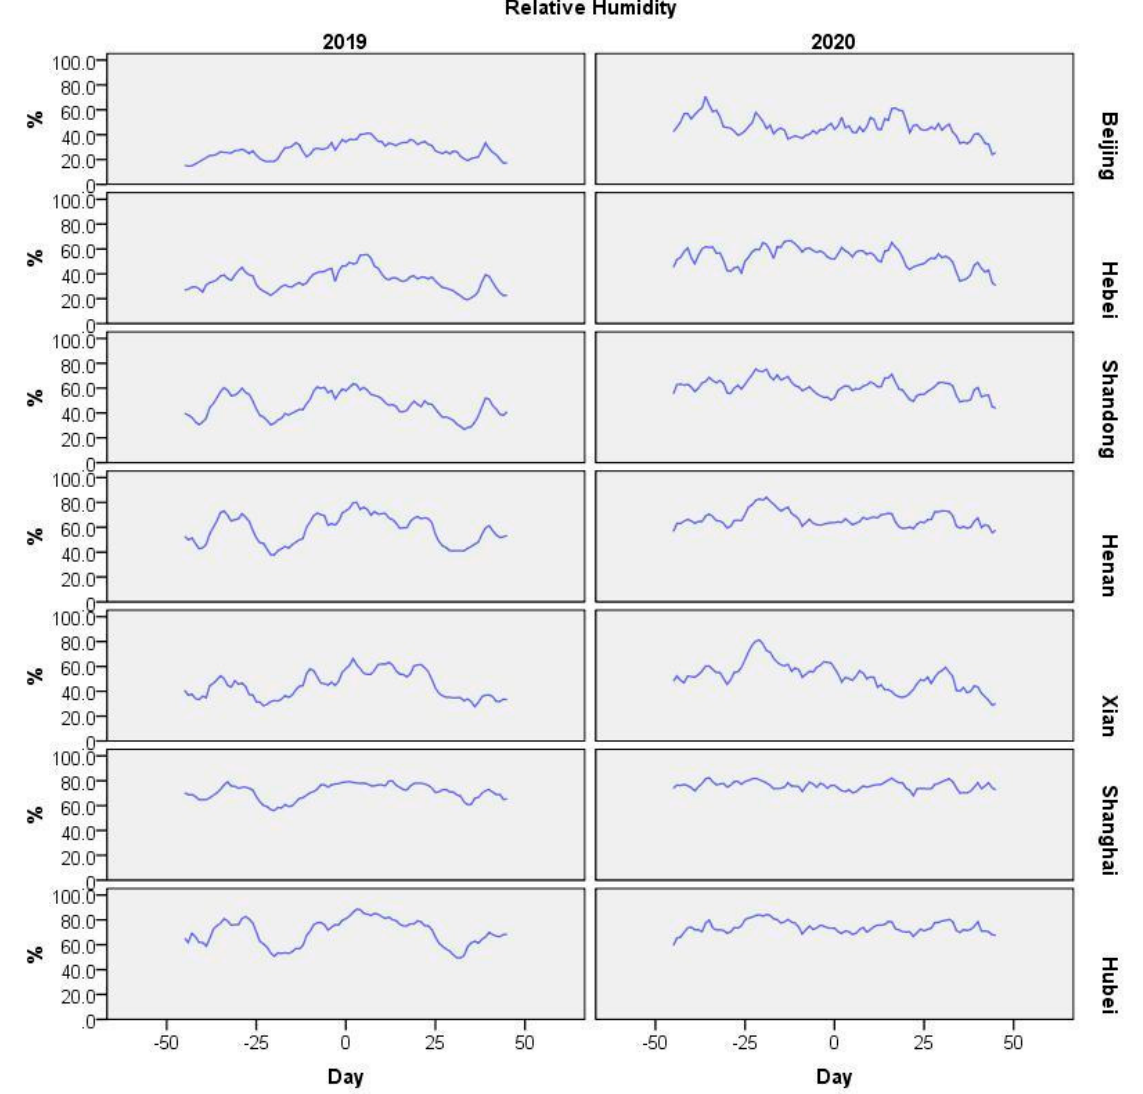
Figure A4. Daily time series of relative humidity during equivalent 91-day timeframes of investigation for 2019 and 2020, across seven regions of China.